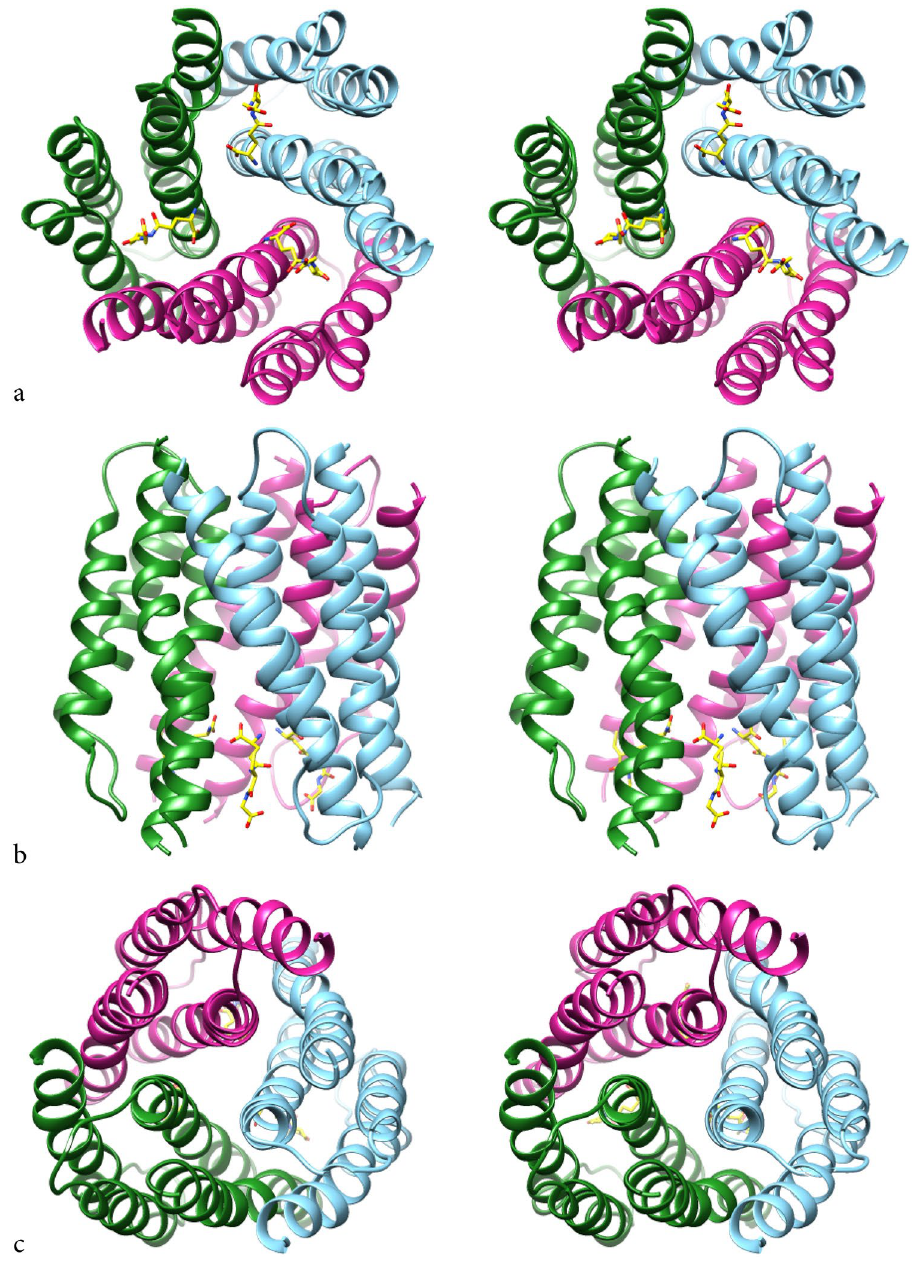
Figure 1. Helical packing of MGST1. Cross-eyed stereo views of the functional trimer with GSH in yellow. ( a ) Cytoplasmic view. ( b ) side view with cytoplasmic side facing down. ( c ) ER lumenal top view. GSH is located between subunits coloured